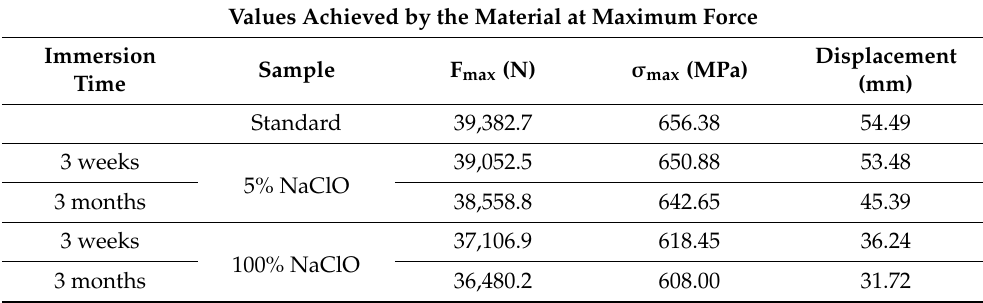
Table 1. Values reached by the AISI 316L after three weeks and three months at maximum force. Values Achieved by the Material at Maximum Force